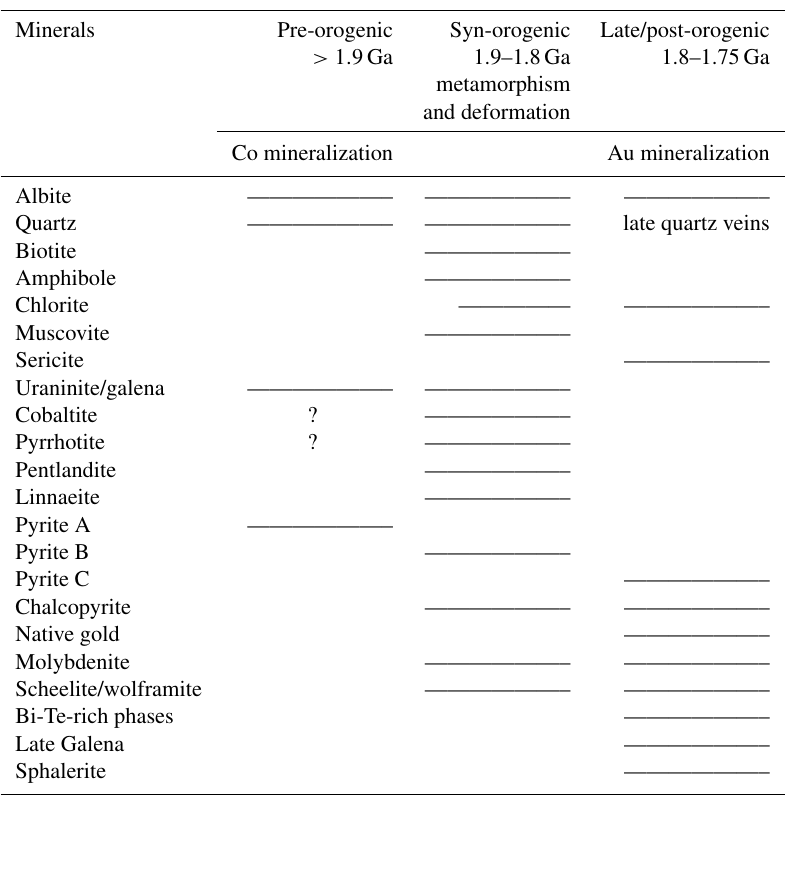
Table 1. Succession of mineralization in association with alteration and the geological evolution of the Peräpohja belt.